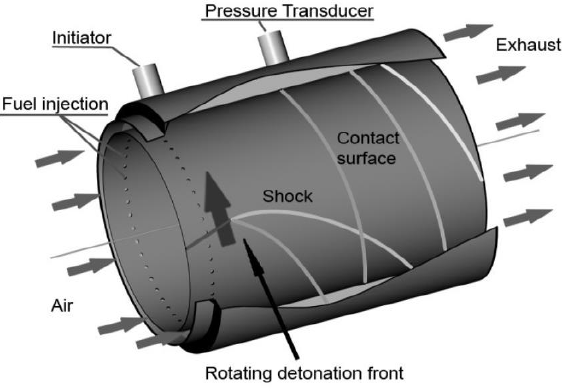
Fig. 4. Schematic diagram of annular detonation chamber [14] Such way of oxidizer and fuel supply is necessary to en- sure quick mixing of both components to form nearly uni- form mixture which can support detonation. In the chamber Fig. 2. Schematic diagram of the first PDE developed at the University of Michigan [5, 14] ports for measurement of detonation parameters. The